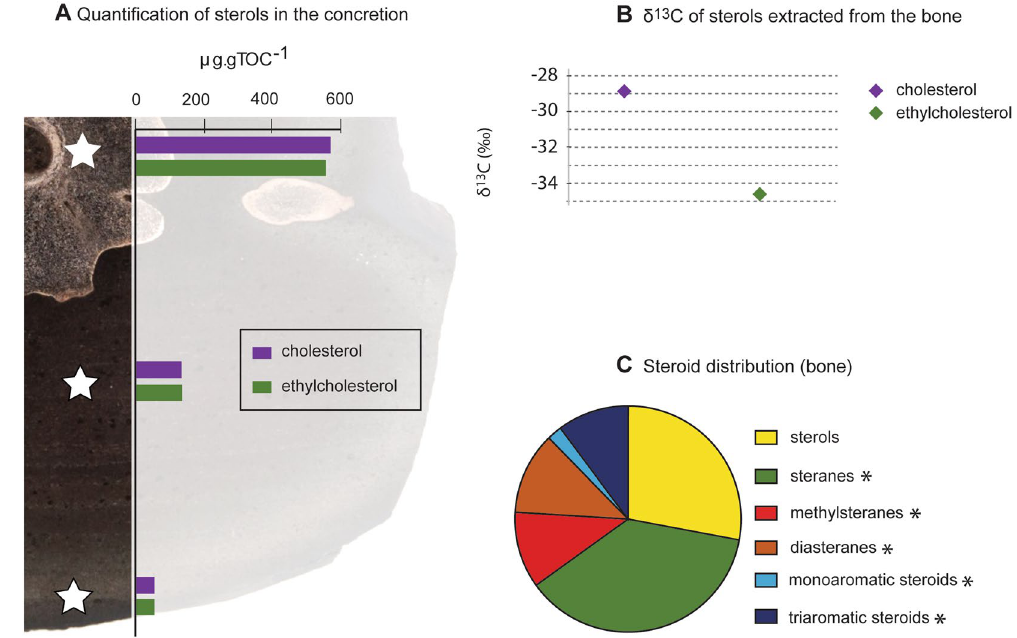
Figure 6. Steroid distribution and compound specific δ 13 C values. ( A ) Sterol distribution within the bone and concretion, showing high concentrations of cholesterol (565 µ g/g TOC) and ethylcholesterol (523 µ g/g TOC) and lower concentrations in the concretion body and rim. ( B ) δ 13 C values (‰ VPDB) of sterols associated with the bone (cholesterol: − 28.9 ± 0.4‰ VPDB; ethylcholesterol: − 34.6 ± 0.4‰ VPDB) from the concretion. The error bars are contained within the symbol. ( C ) Relative proportion of compound classes within the fossil, dominated by sterols and steranes representing the end-members of the diagenetic sequence. * Diagenetic end